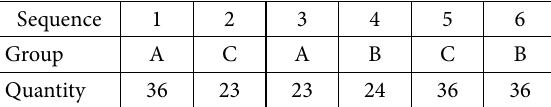
Table 2. The yard stowage map of export containers in container yard Bay